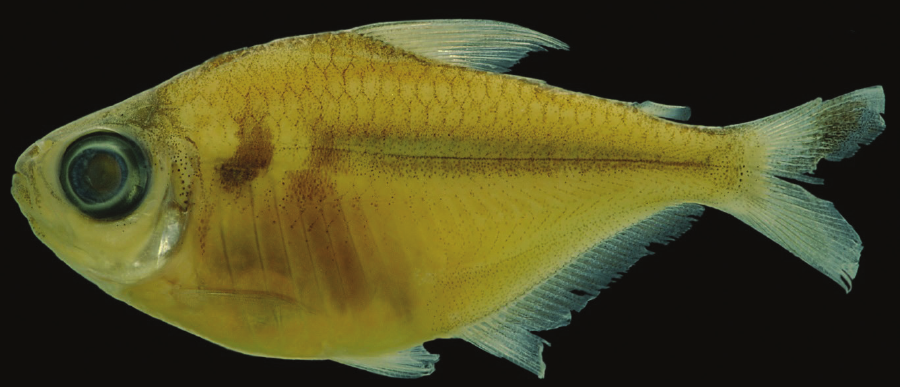
Figure 2. Moenkhausia megalops , INPA 48895, 41.9 mm SL, Brazil, Amazonas State, rio Japurá